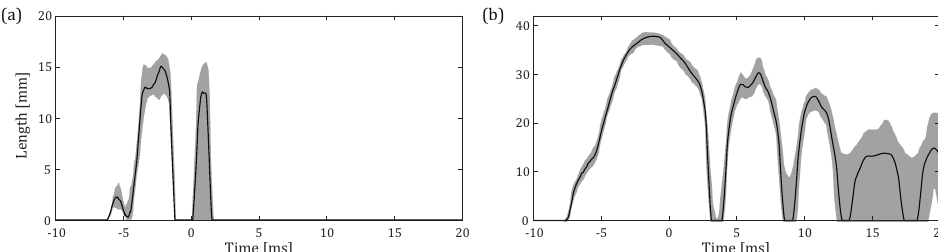
Figure 3. Separation length for 0.15 vapor threshold (black) and ± 0.05 deviation (grey). ( a ) For Re = 1633, the length seemed robust for the first separation, while the second separation was highly influenced by the threshold value. ( b ) For Re = 2239, the first three separations lengths were not very affected by the threshold